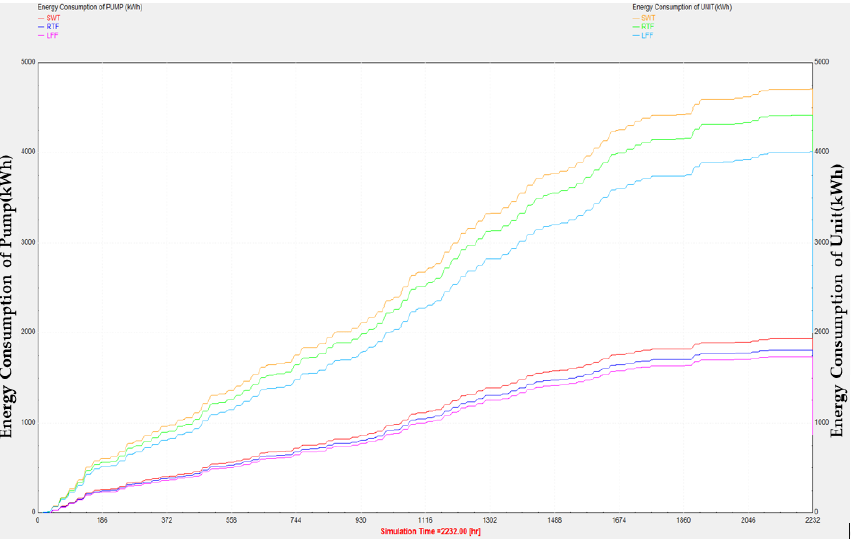
Figure 13. The simulation results of energy consumption under three different control strategy.